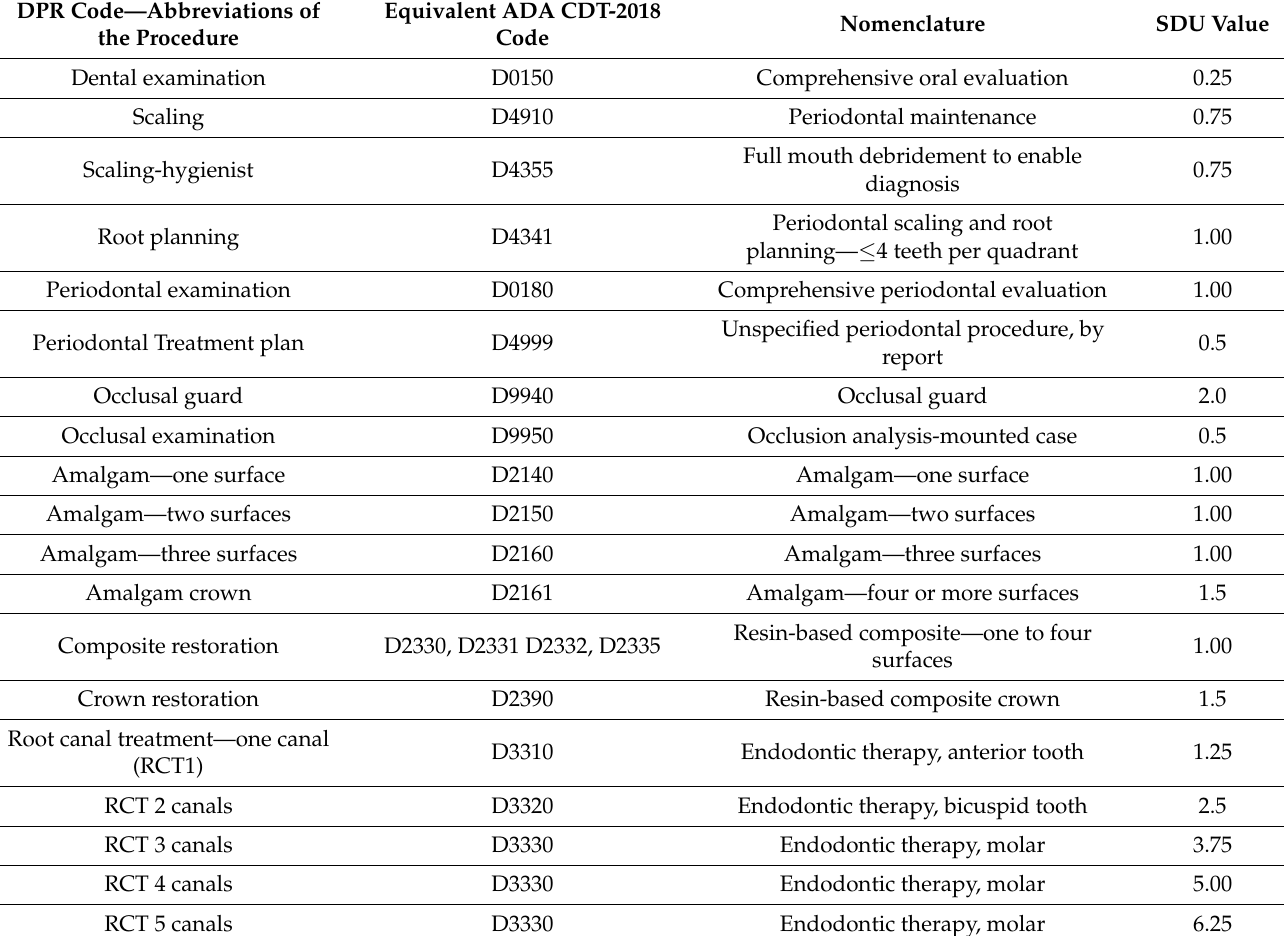
Table 1. Standard dental unit (SDU) scoring system: Nomenclature of the standardized dental patient record (DPR) codes for dental procedures and their equivalent nomenclature in the American Dental Association (ADA) Current Dental Terminology